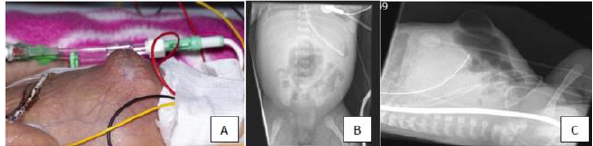
Fig. 1(A): Photograph of case 1 on day 23 of life, showing right peri-umbilical swelling;(B): AXR of Case 1 on day 23 of life showing localized gas shadow at the site of peri- umbilical swelling; (C): Lateral x-ray of the abdomen of case 1 on day 23 of life showing dilated bowel and air filled cyst at the site of peri-umbilical swelling.